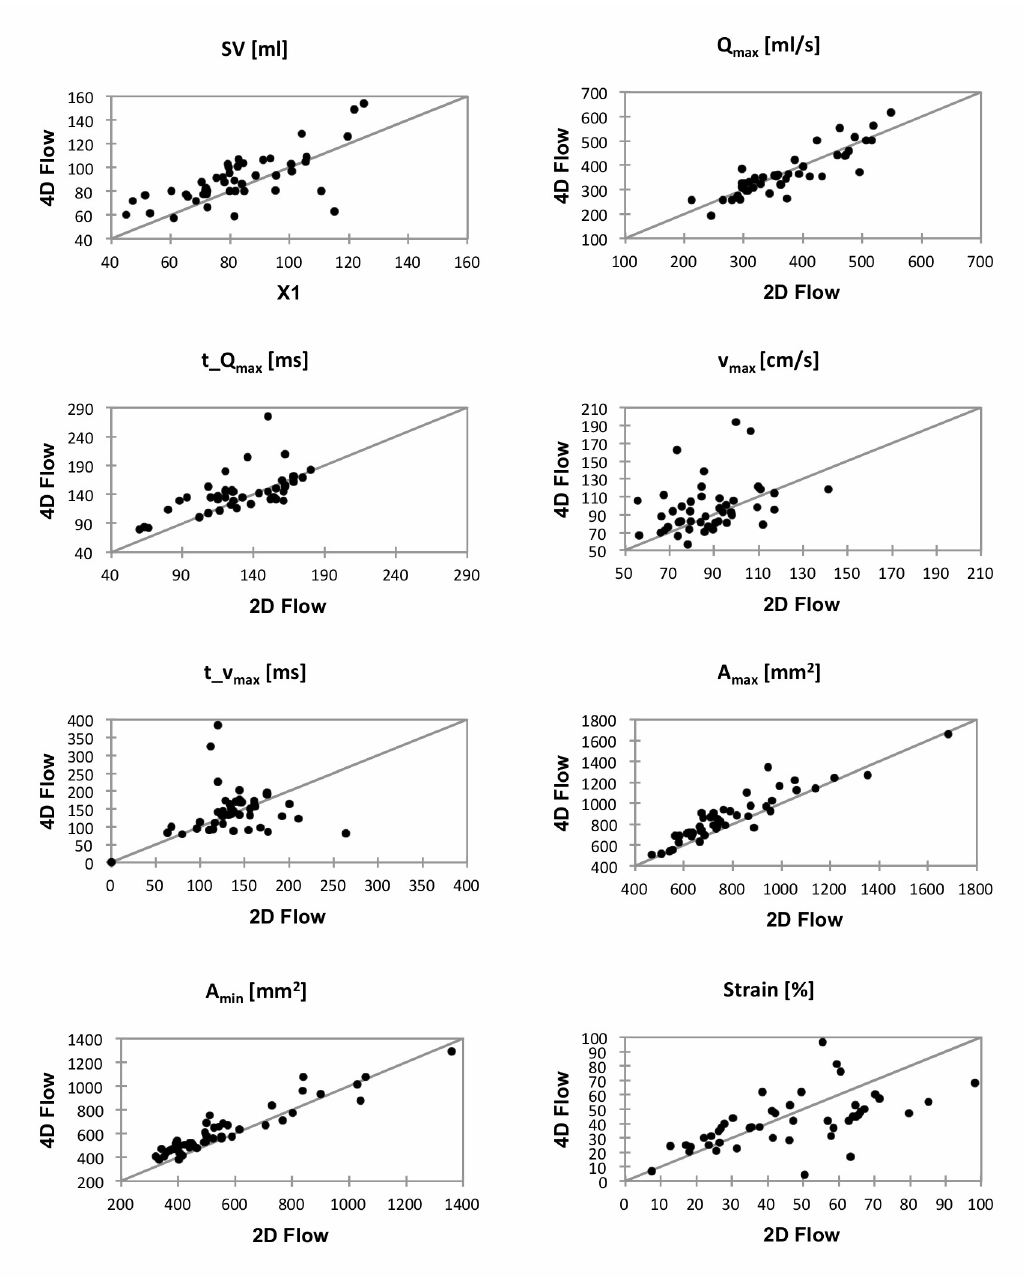
Fig 4. Scatter plots for all evaluated hemodynamic and anatomical parameters for the comparison between 4D Flow and 2D Flow MRI.